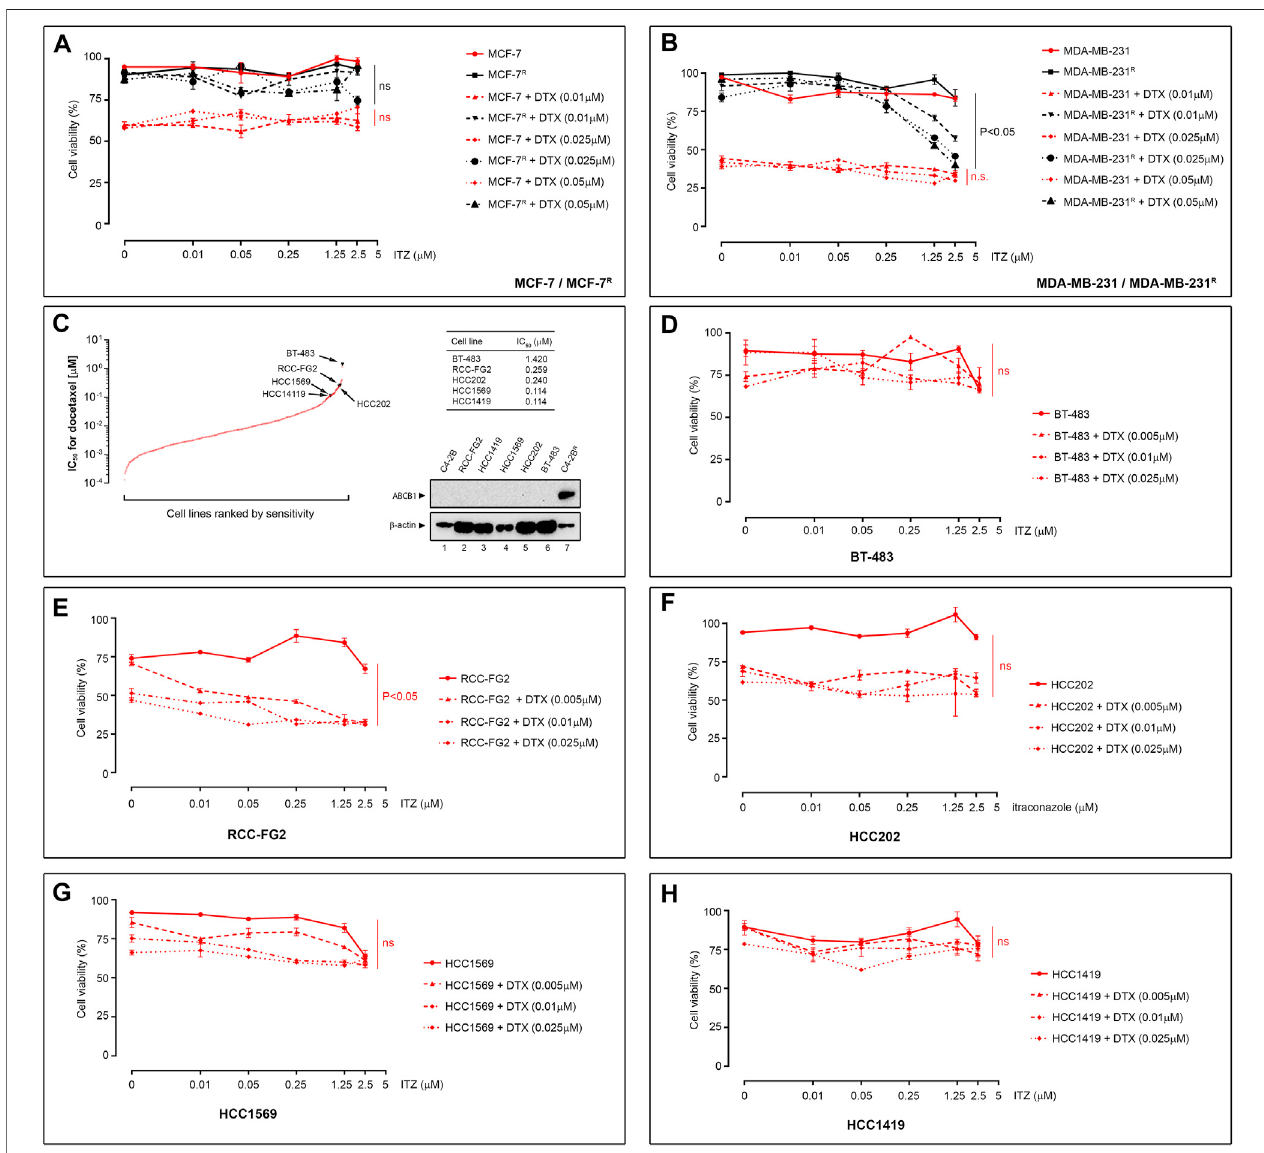
FIGURE 3 | Effect ofITZ on DTX-resistantcancer cells. (A) Effect ofITZ on DTX-resistant MCF-7 R and (B) MDA-MB-231 R cells breast cancer cell lines. Combining increasingconcentrationsofITZwithDTXshoweddose-dependentreversalofdrug-resistanceinDTX-resistantPCacelllines (C) PlottedIC 50 valuesforDTXGenomicof Drug Sensitivity in Cancer project platform dataset. Five cells lines showing no ABCB1 expression (western blot analysis inset) were selected and the effect of ITZ determinedalone and incombinationwithDTXforthe (D) BT-483, (E) RCC-FG2, (F) HCC202, (G) HCC1569 and (H) HCC1419. Cell viabilitywasmeasured using astandardMTTassay,followingexposureofcellstovaryingconcentrationsofdocetaxelfor72 h. Allplotted valuesarenormalized totheuntreatedcontrol.Signi fi cance in differences in best- fi t values in the IC 50 values of the dataset were tested by two-way ANOVA. ns: non-signi fi cant p -value.